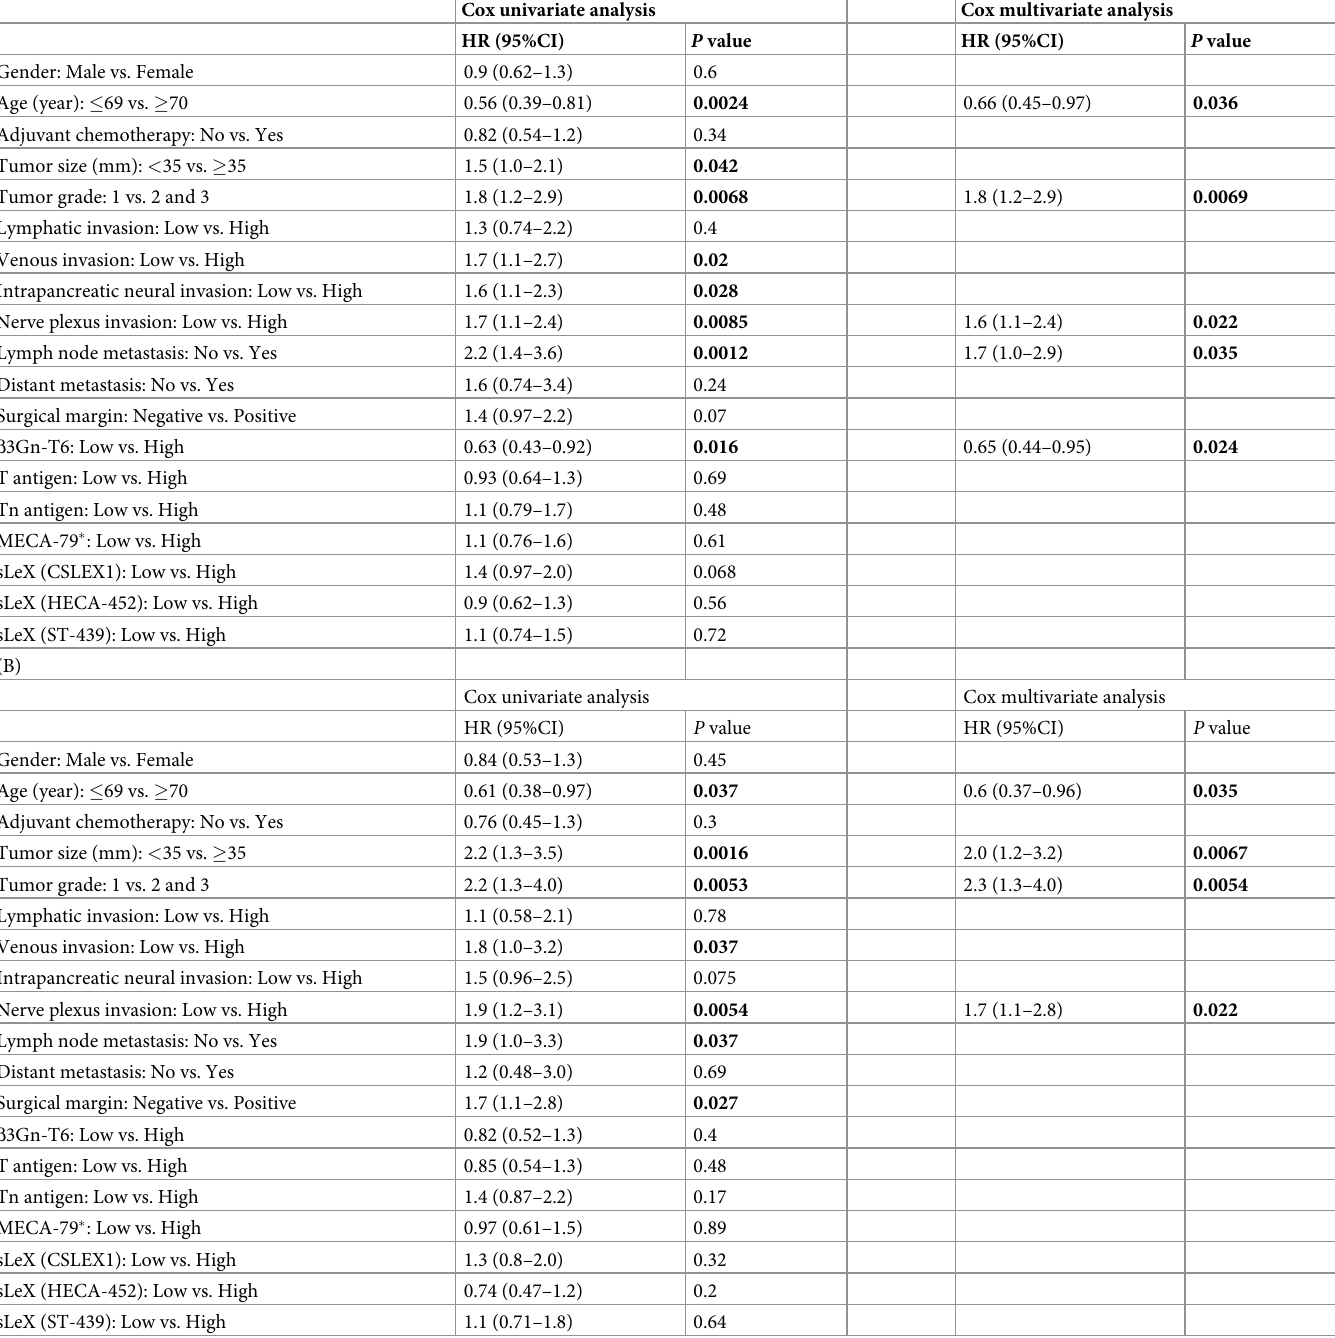
Table 5. Univariate and multivariate analyses of prognostic factors associated with disease-free survival (A) and and overall survival (B) in patients with pancreatic ductal adenocarcinoma (n =